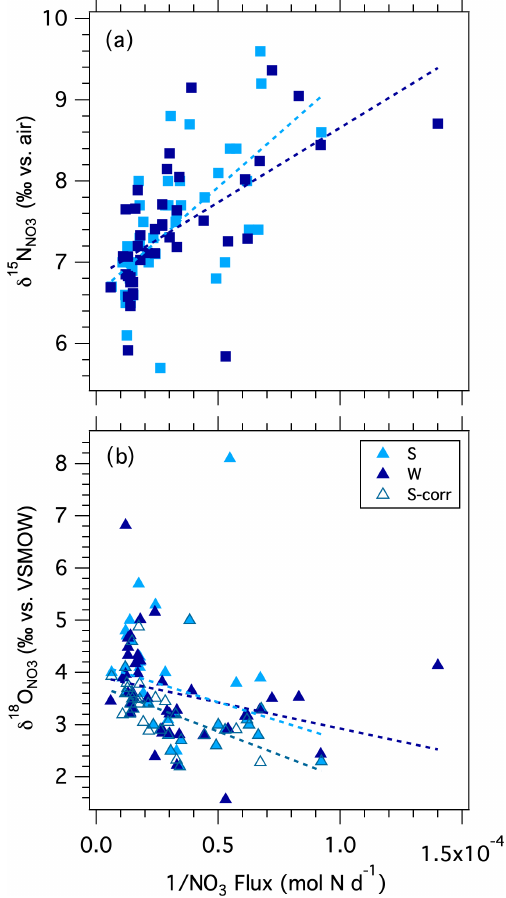
Figure 8. Modified Keeling plot of NO − Westerly and Stillman bridges vs. the inverse of the daily NO − flux: (a) δ 15 N NO vs. the inverse of the NO − 3 and δ 18 O NO corrected for atmospheric NO − 3 NO − 3